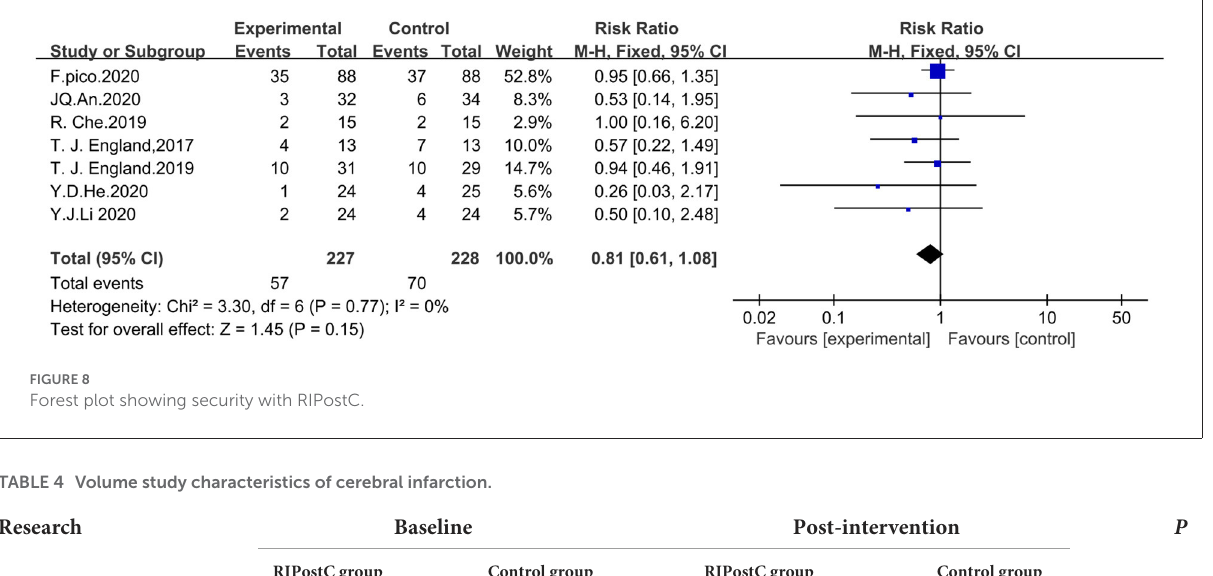
TABLE 4 Volume study characteristics of cerebral